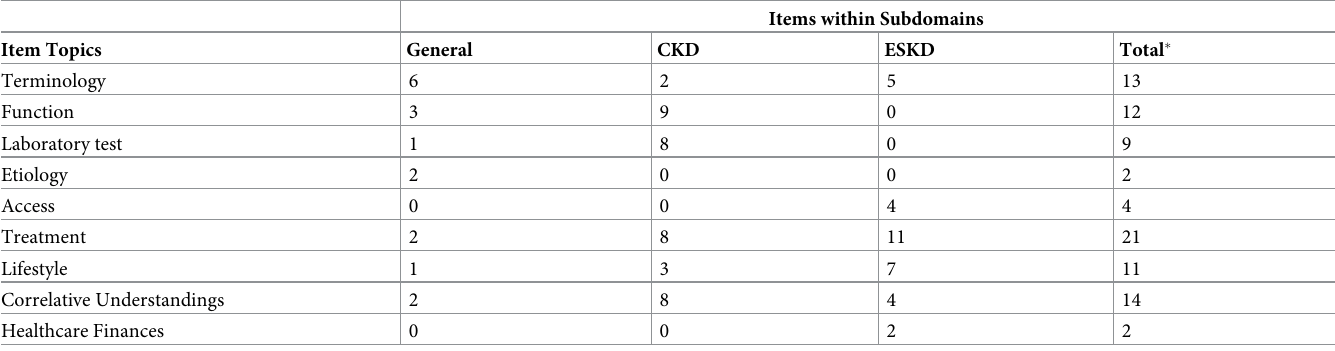
Table 1. Number of items within topics, within scale